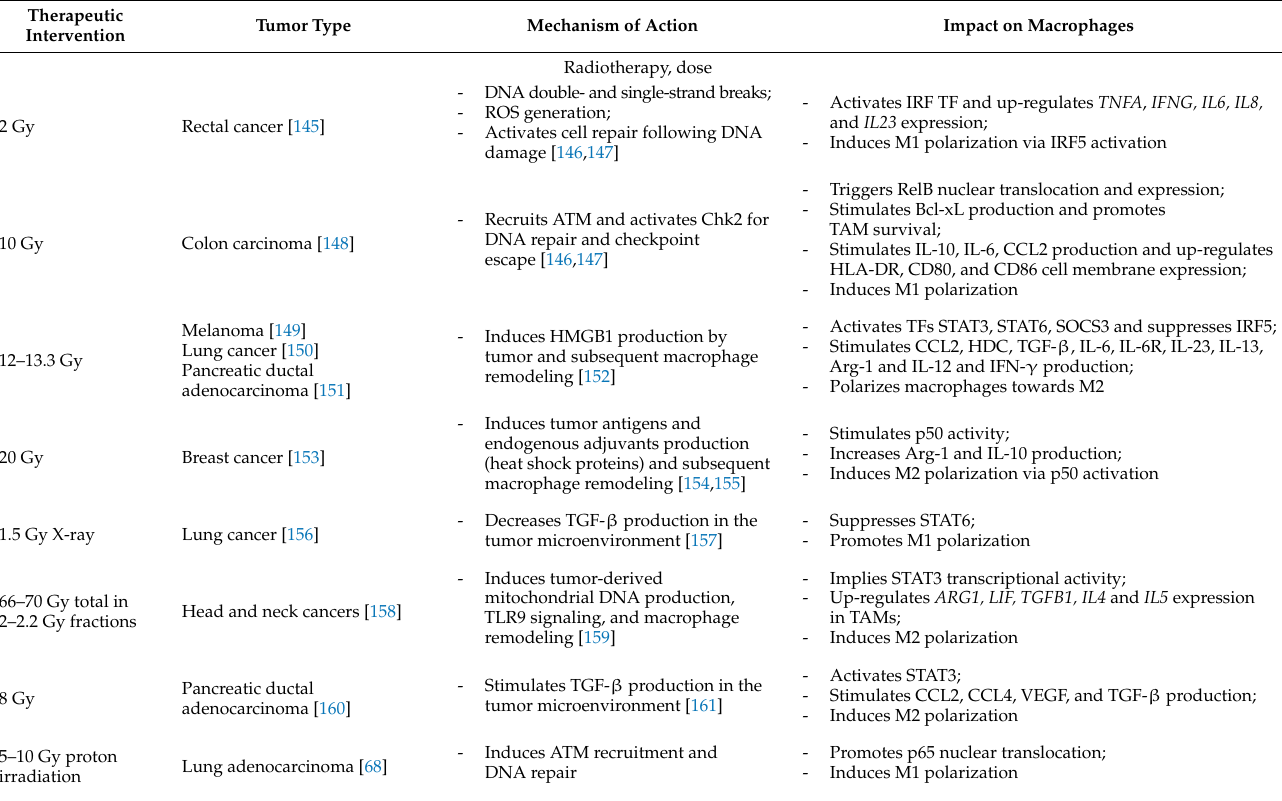
Legend and abbreviations used in Table 3. Treatment (column 1) strategies applied for majority of cancer types (column 2) induce principal alterations in cancer and tumor-associated cells impacting cell survival and metabolism (column 3). The therapeutic interventions additionally exhibit pro- or anti-inflammatory effects mediated by macrophages (column 4). Gy—Gray (Units); γ —gamma-irradiation; DNA—deoxyribonucleic acid; RNA—ribonucleic acid; Th2—T helper cell 2; ADP—ribose-adenosine diphosphate ribose;